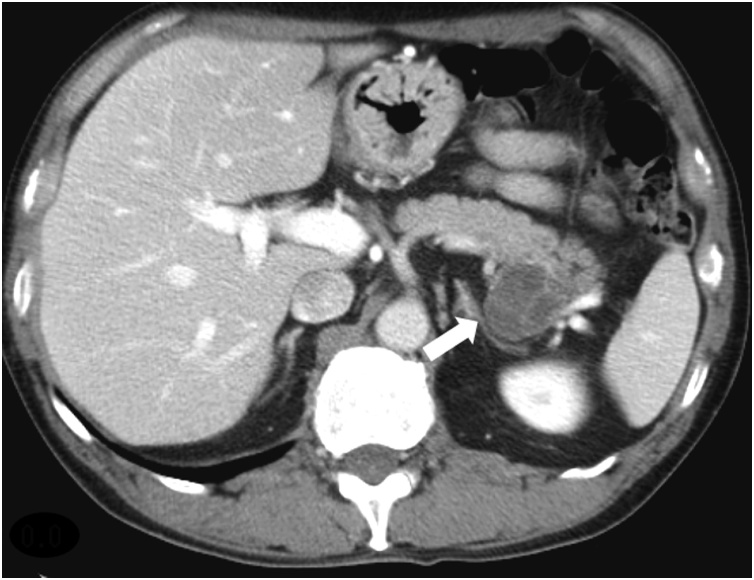
Computed tomography (CT): Enhanced CT showed enhancement of the cystic wall and septa while the cystic contents appeared unenhanced (arrow).